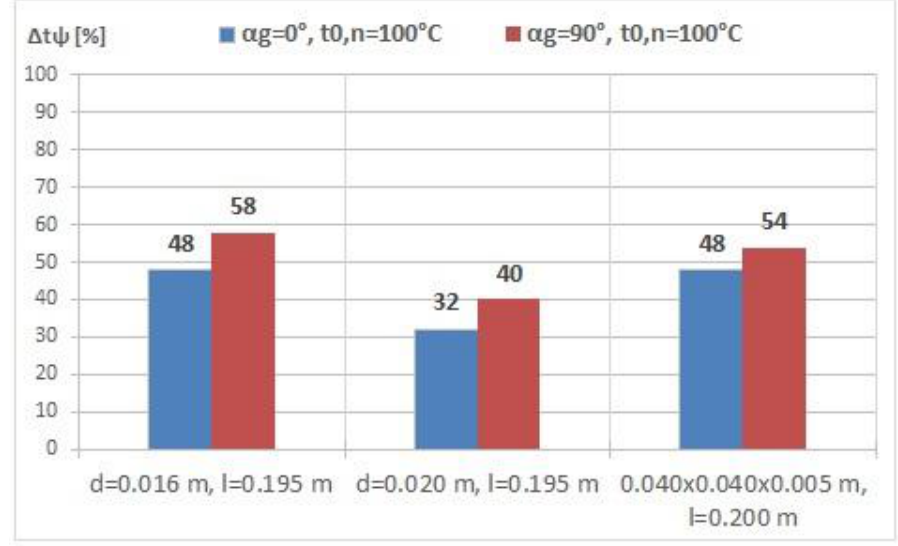
Figure 15. The compared ∆ t ψ = 100 − t ψ [ % ] temperature loss, corresponding to t O , n = 100 ◦ C.